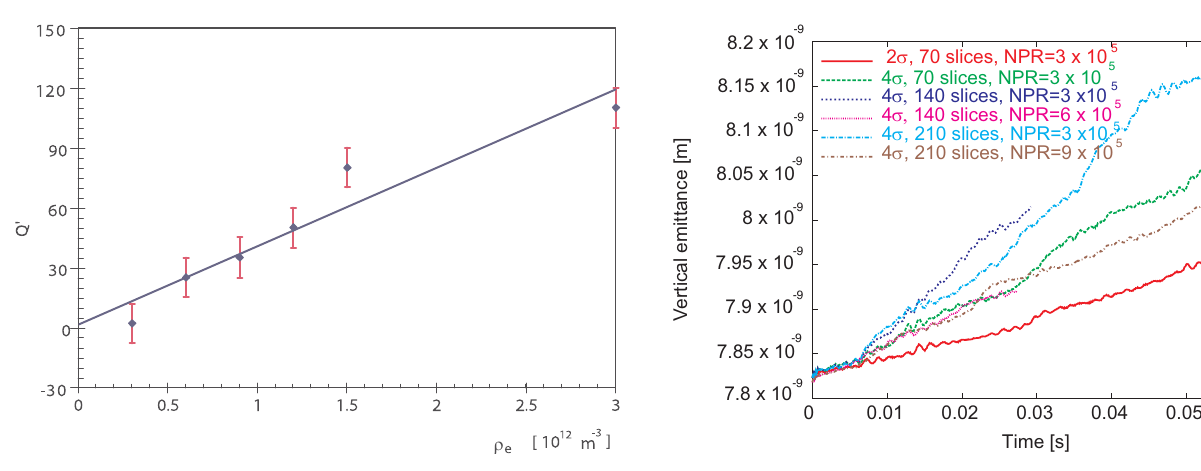
FIG. 11. (Color) Chromaticity as a function of the electron- cloud density level at which the transition between the two regimes occurs in the simulation.